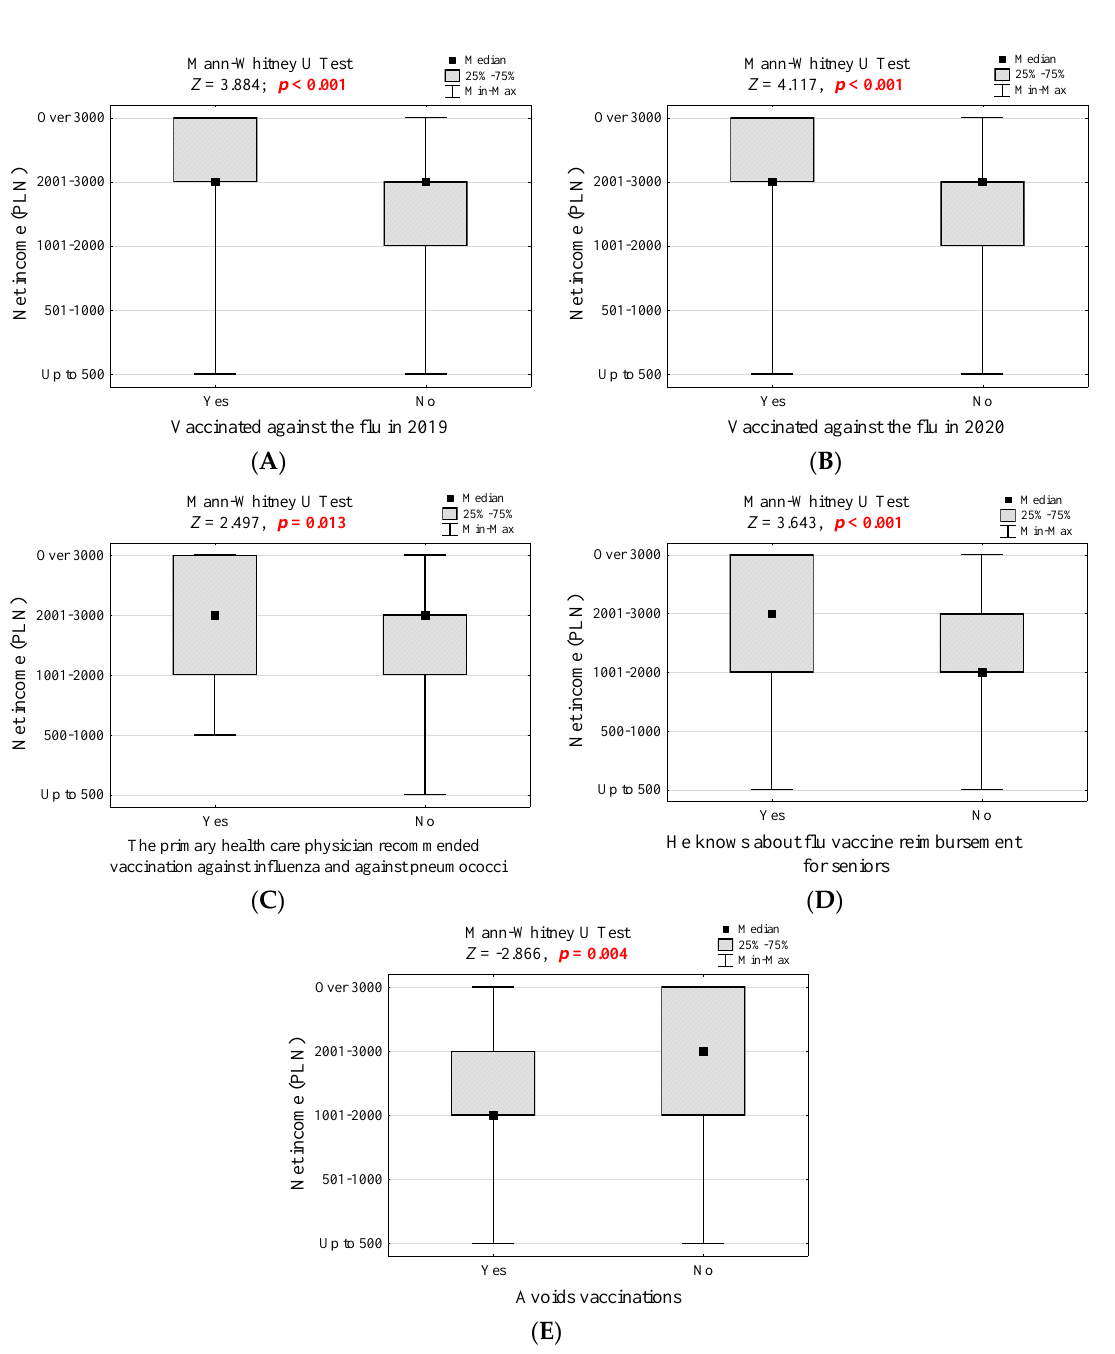
Figure 1. ( A ) Monthly net income per person in the household among groups differing in influenza vaccination in 2019; ( B ) Monthly net income per person in the household among groups differing in influenza vaccination in 2020; ( C ) Monthly net income per person in the household among groups of people with or without a recommendation from a primary care physician for influenza and pneumococcal vaccination; ( D ) Monthly net income per person in the household among groups of people who differ in the knowledge of influenza vaccine reimbursement for seniors; ( E ) Monthly net income per person in households that differ in influenza vaccination avoidance due to possible complications, and the significance test results.